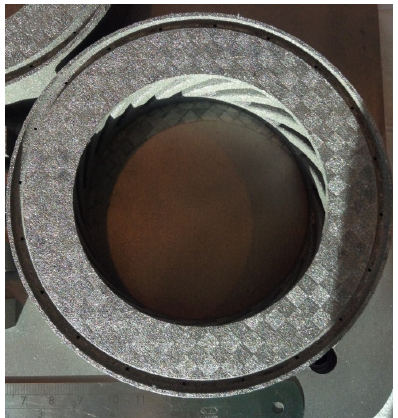
Figure 1. An image of Selective Laser Melting (SLM)-processed Fe blade tooling attached to the substrate.